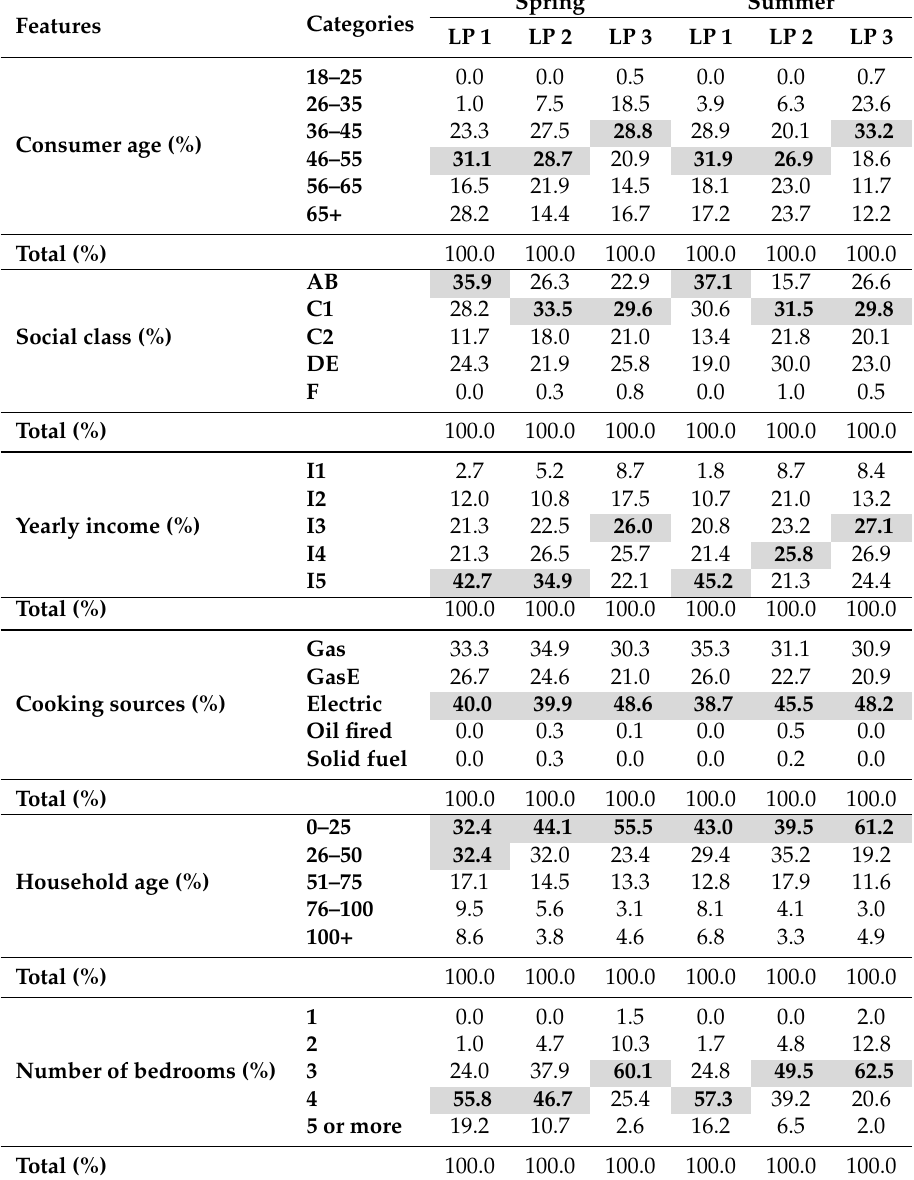
Table 5. Key features for each normalized LP in spring and summer, where the percentage values of the most representative categories within each cluster are highlighted in bold